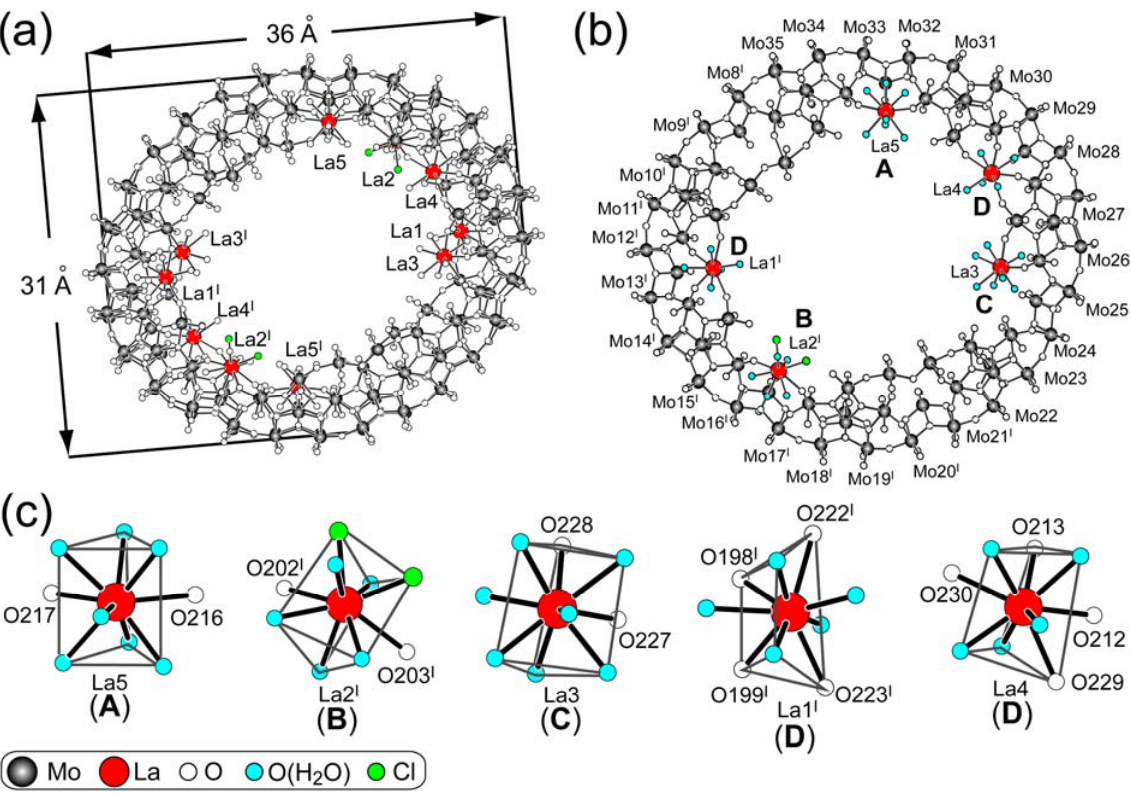
La } (a), four (A-D) modes for the coordination 134 10